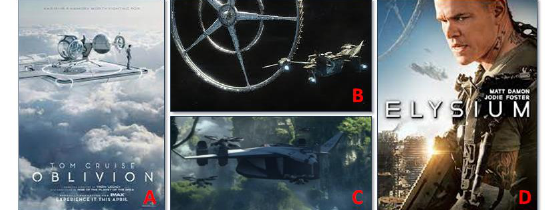
Figure 1 . Im. A is from movie Oblivion (Oblivion, 2013), Im. B and D are from movie Elysium (Elysium, 2013), Im. C is a manned Aerial Vehicle in Avatar Movie (Avatar,